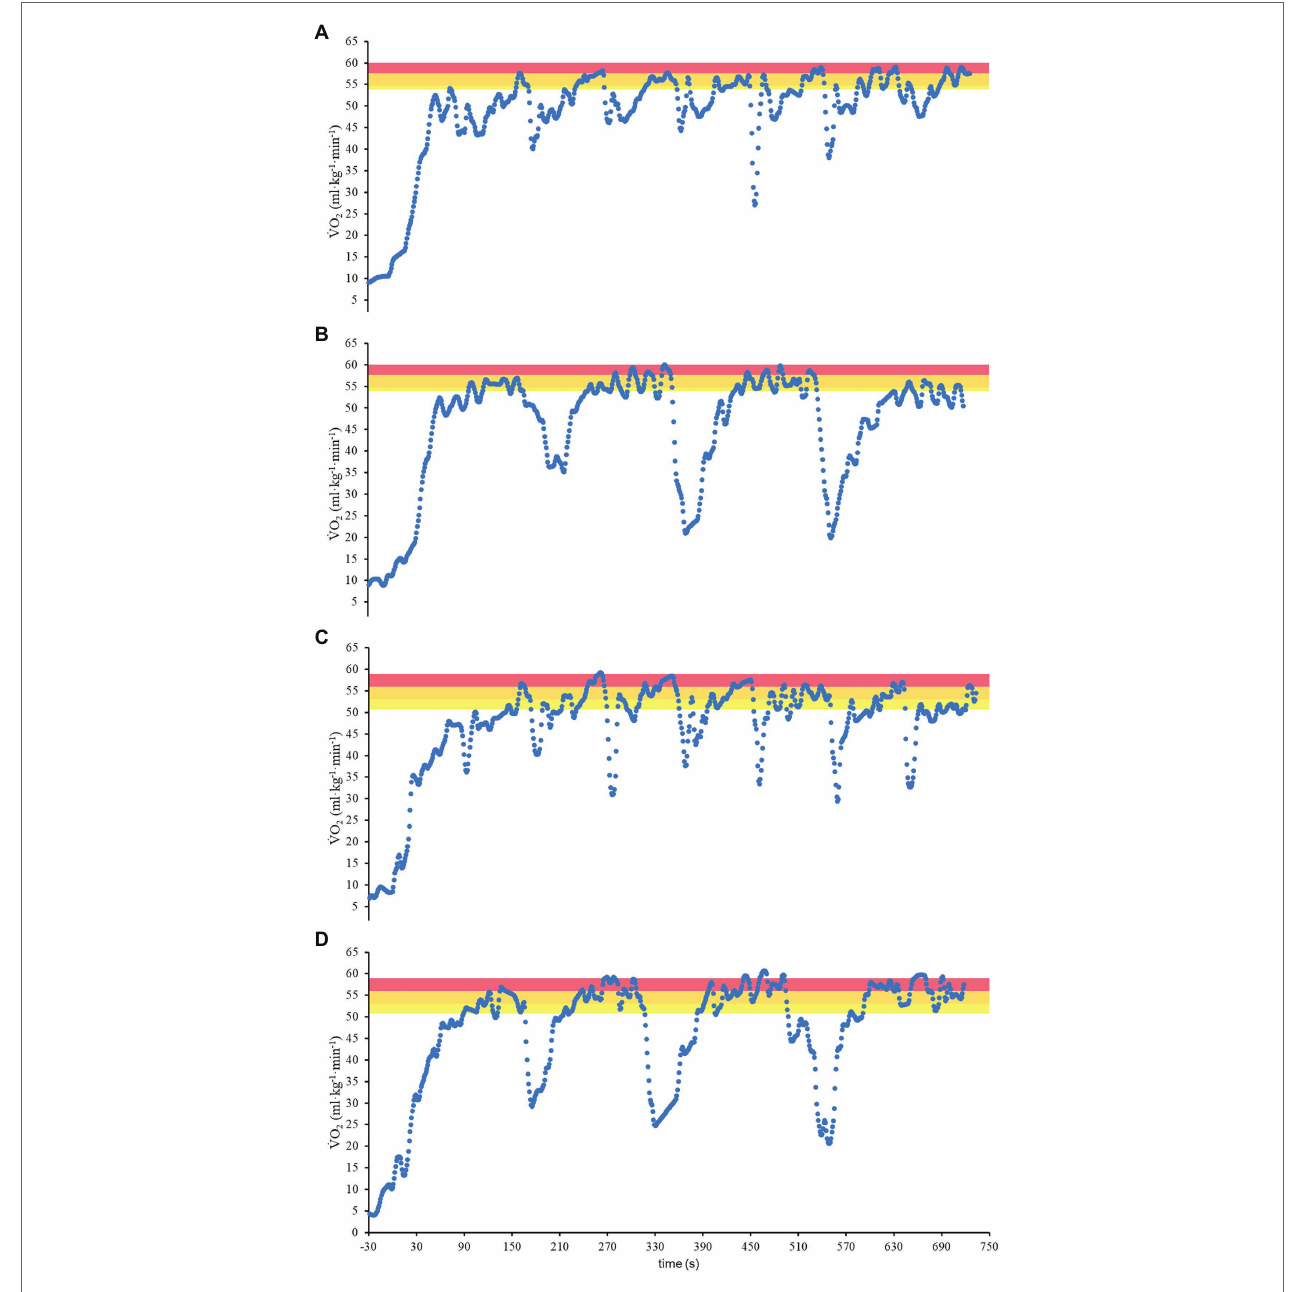
FIGURE 3 | ⩒O 2 response during IT 8x100 (A,C) and IT 4x200 (B,D) for male (A,B) and female (C,D) swimmers. The yellow, orange, and red shadow areas highlight the t@VT 2 , t@90%, and t@95% of ⩒O 2peak ,